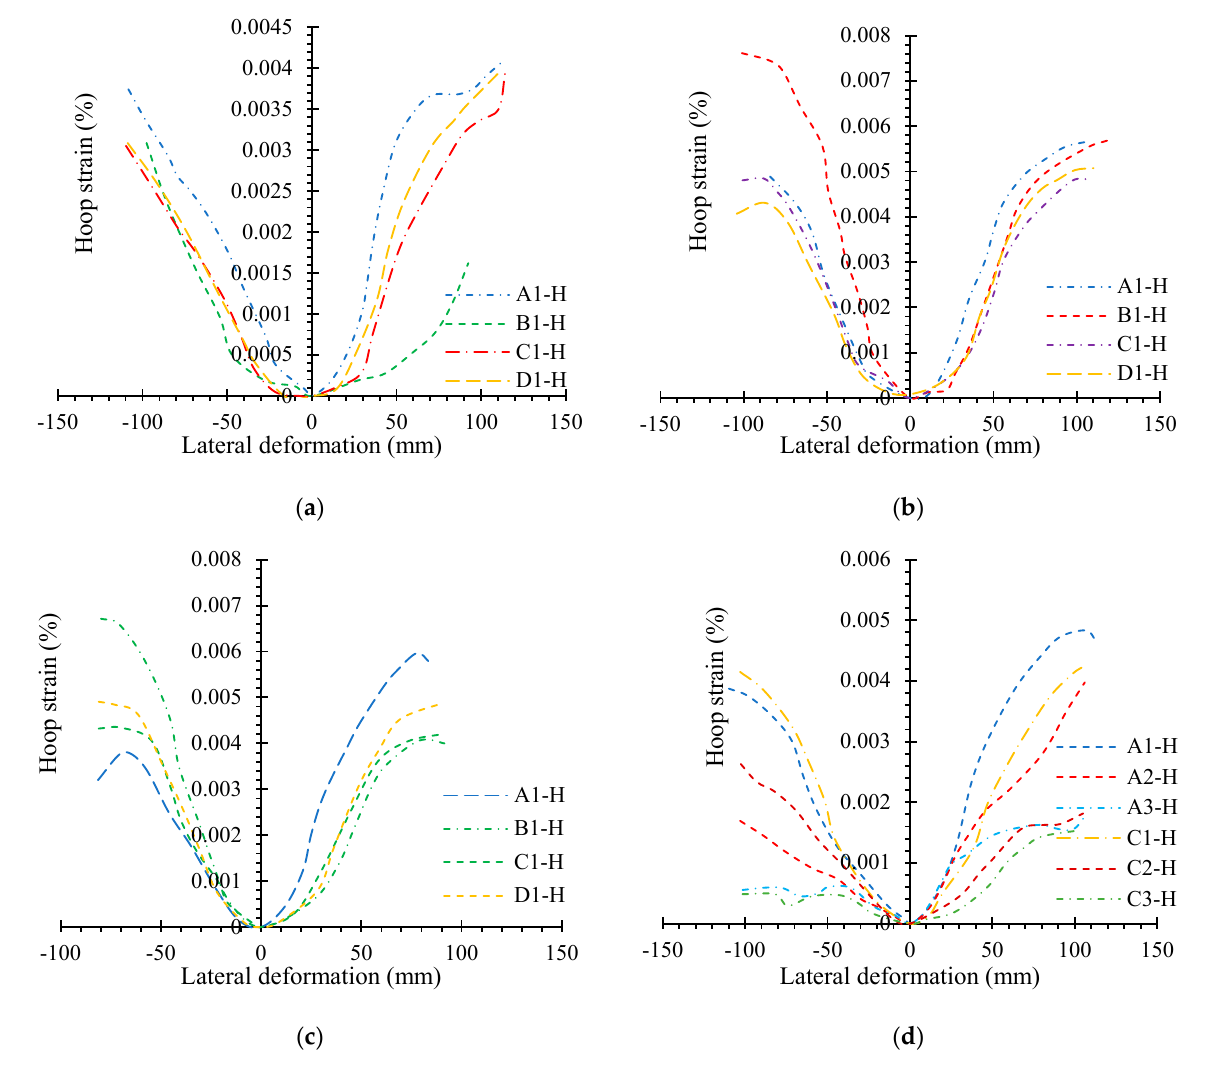
Figure 9. Hoop strains of GLT: ( a ) RAGC100-0.2-STT8 for similar elevation; ( b ) RAGC50-0.2-STT8 for the same elevation; ( c ) RAGC50-0.2-STT10 for diverse elevations; ( d ) RAGC50-0.4-STT8 for the same elevation.